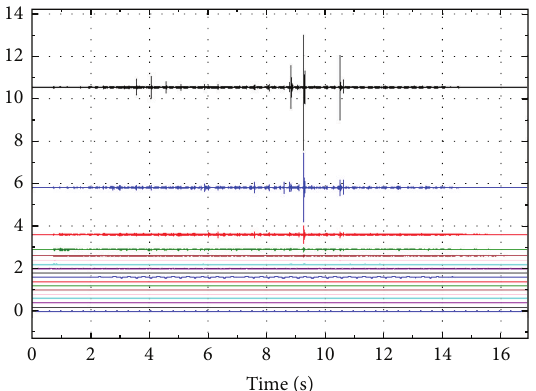
Figure 26: EEMD analysis results of original microseism signals from 4# sensor in working condition 29.